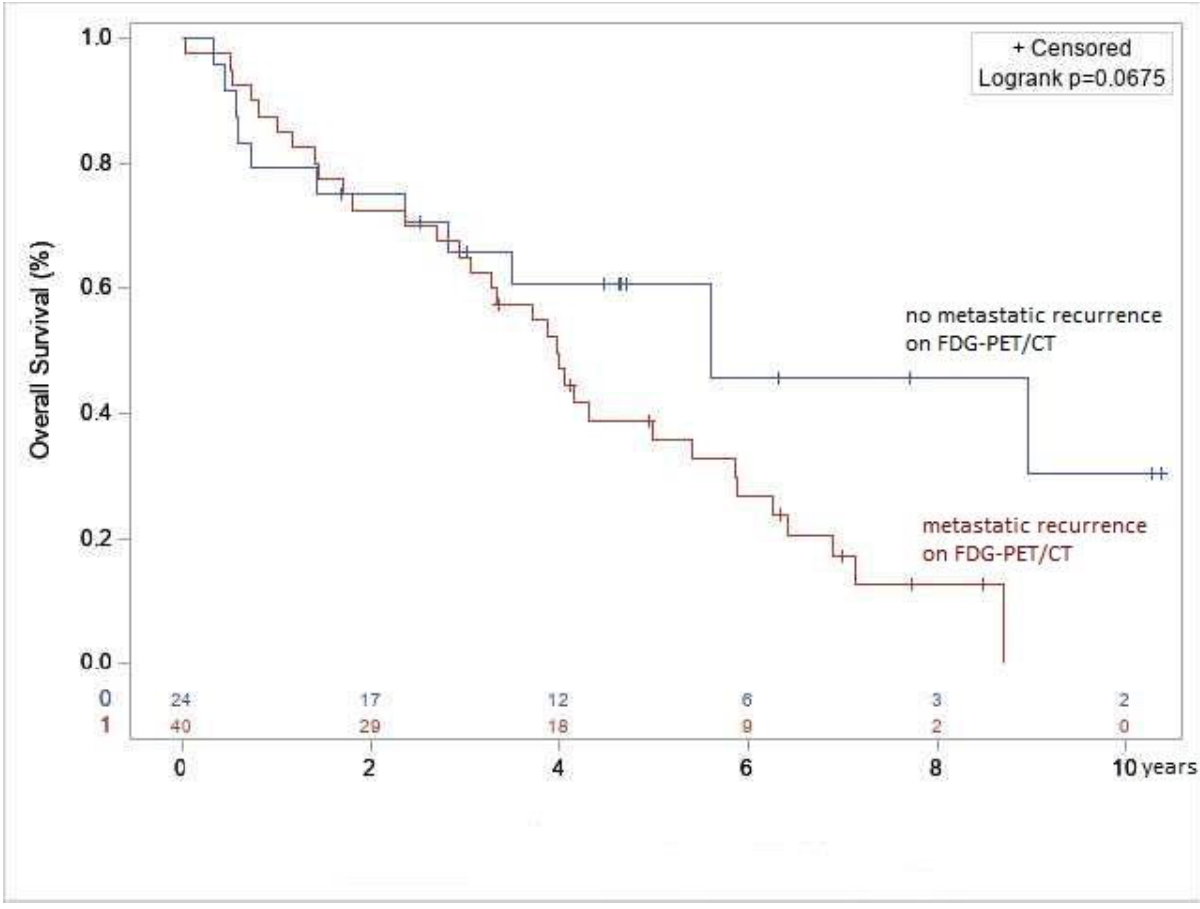
Figure 6. Kaplan-Meier analysis for specific survival in patients with metastatic recurrence and patients with no metastatic recurrence or locoregional recurrence on PET/CT imaging.